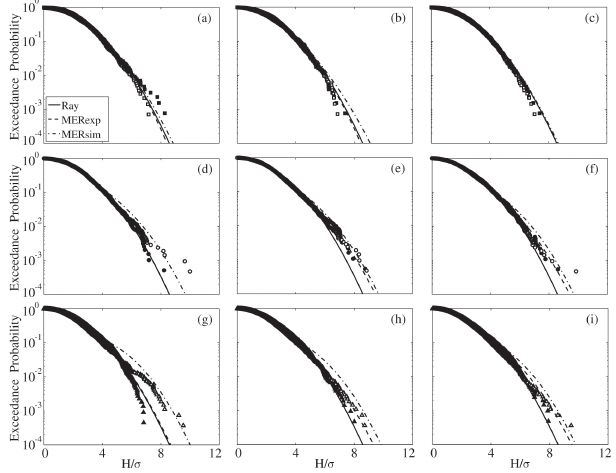
Fig. 5. Exceedance distributions of scaled wave heights. The three rows correspond to three typical sea states listed in Table 2, i.e., case 4, case 13 and case 23. The three columns present the results obtained from Gauges set at 20, 80 and 120m away from the wave maker, respectively. The solid line, dash line and dot-dash line mean Rayleigh distribution, MER models in experiment and in simulation in sequence. The full and empty marks still have the same meaning as